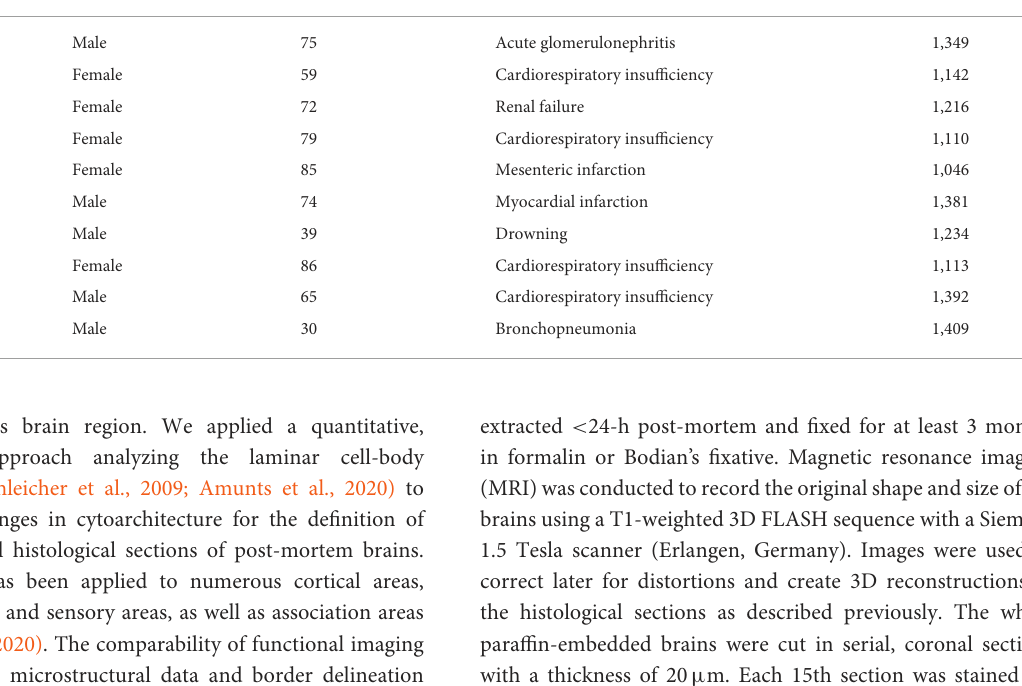
TABLE 1 Post-mortem brains obtained from the Body Donor Program were used for the cytoarchitectonic analysis of the anterior DLPFC. Brain